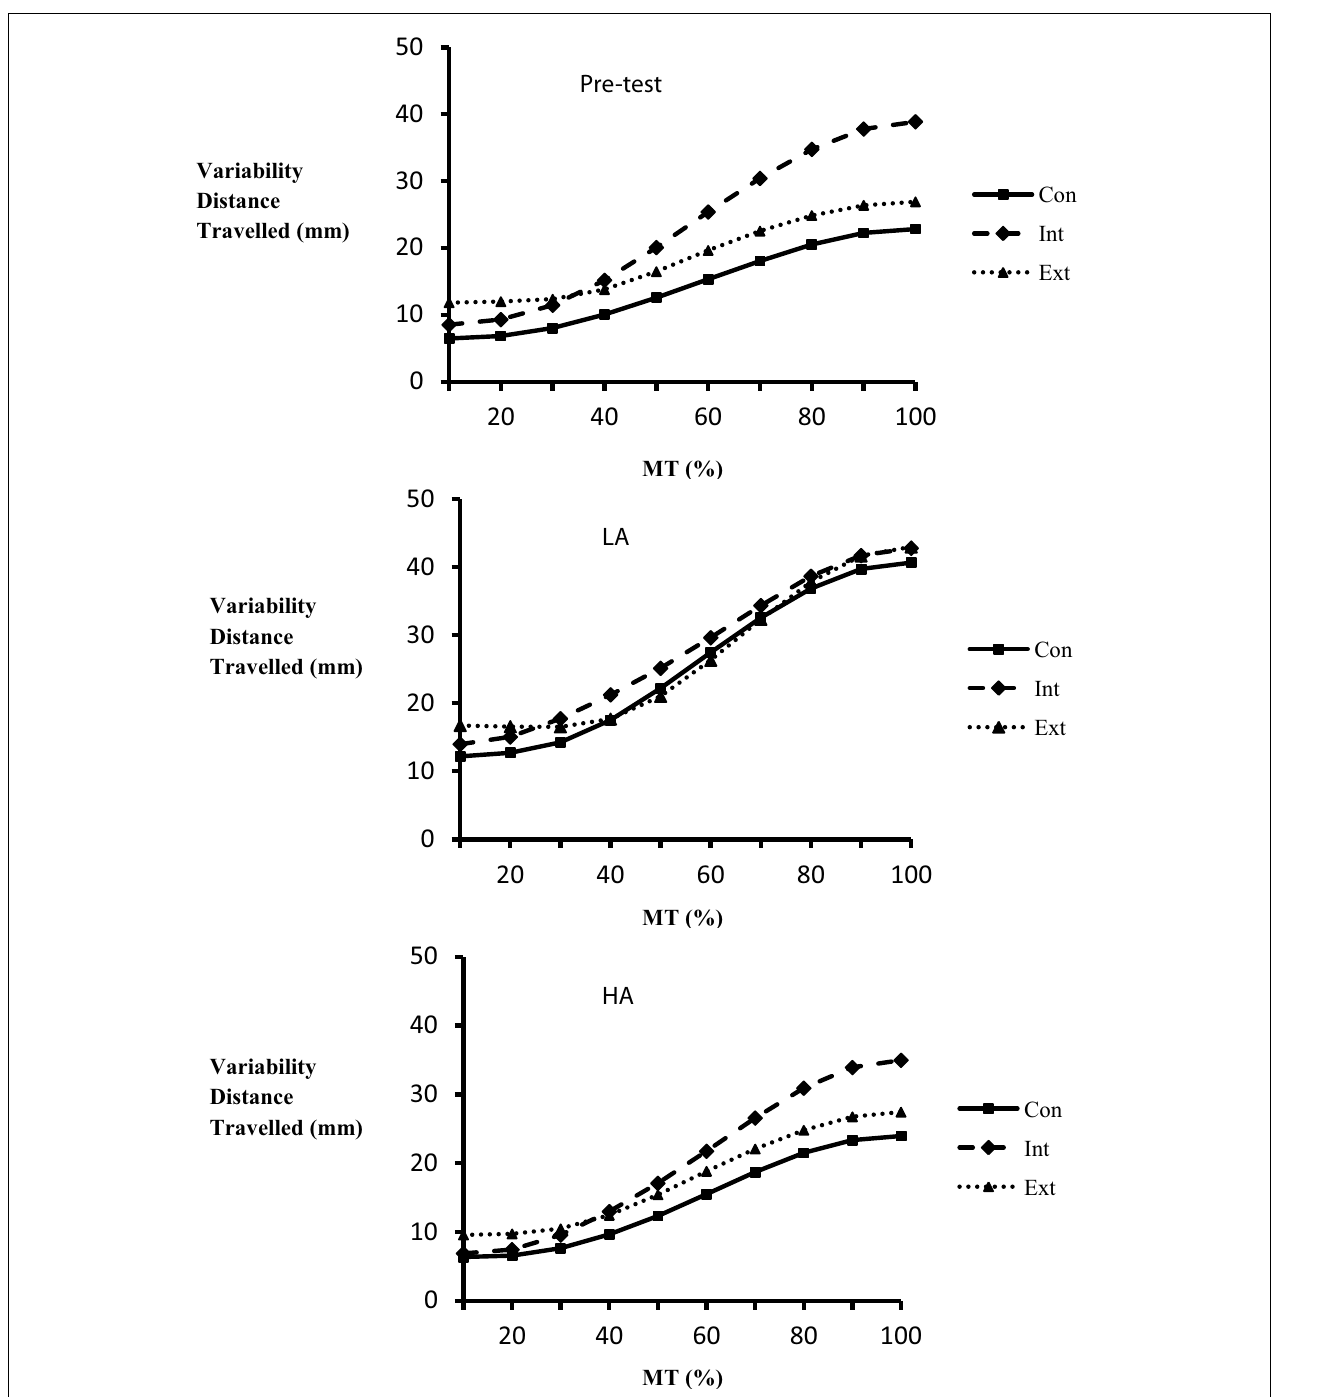
FIGURE 4 |Variability in distance traveled at every 10% of MT for the back-swing as a function of group (Con, control; Int, internal; Ext, external) and experimental phase (Pre, pre-test; LA, low anxiety; HA, high anxiety).